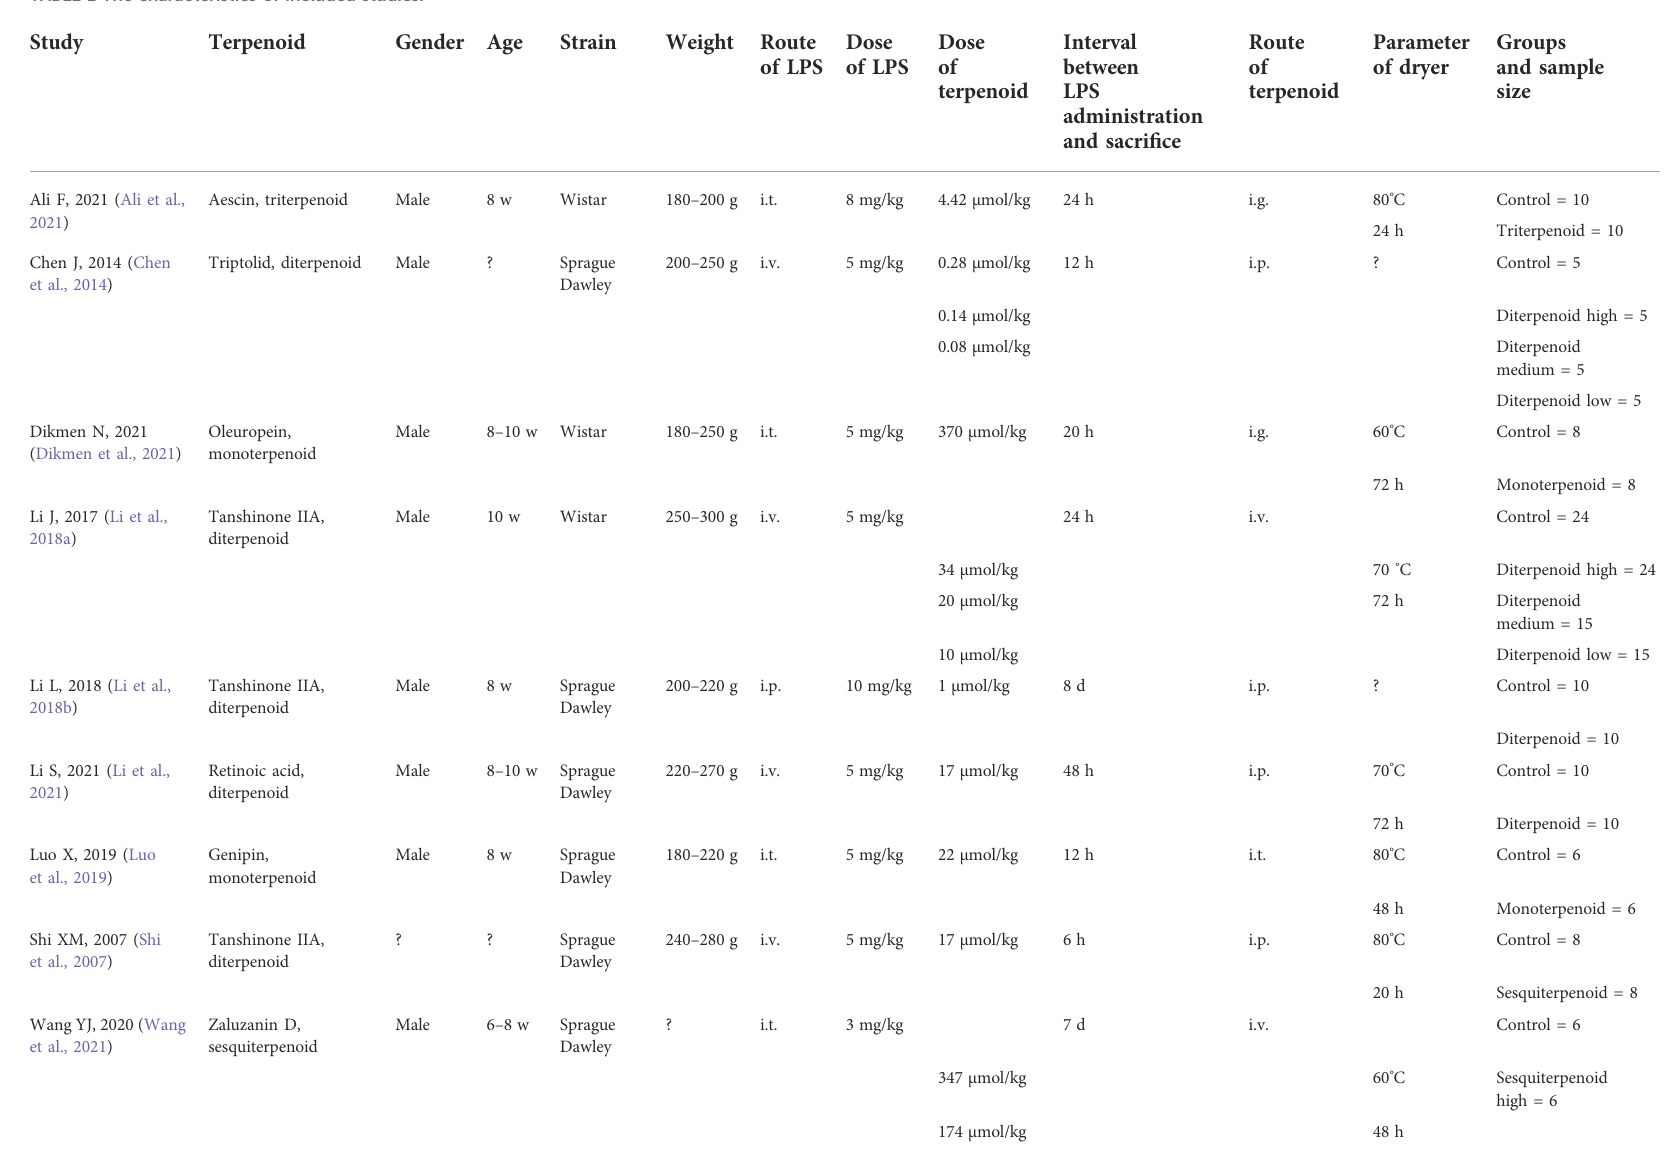
TABLE 1 The characteristics of included